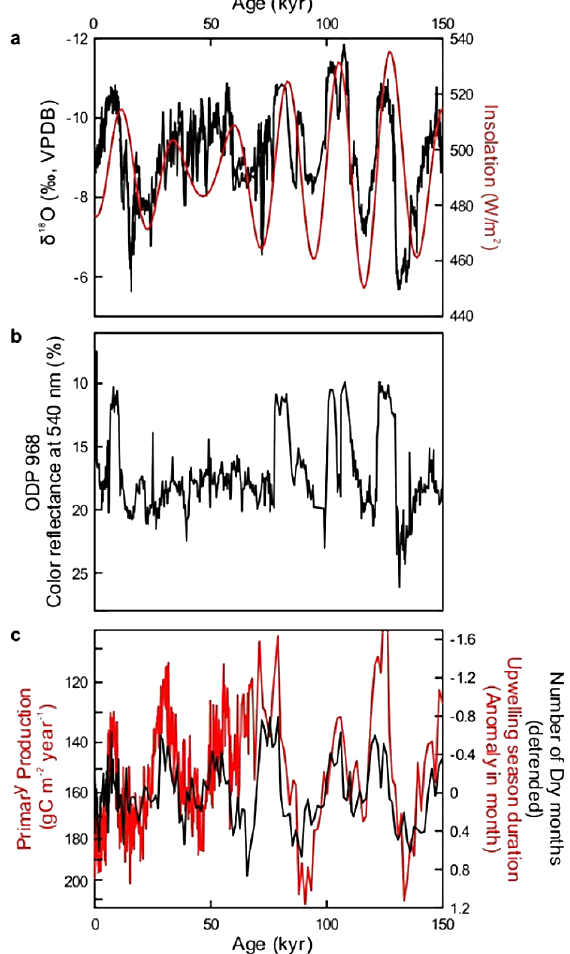
Figure 14. Comparative changes of Asian, North African and Aus- tralian monsoons over the past 150ka. (a) Asian monsoon variabil- ity inferred from the stalagmite δ 18 O record (black) from Hulu and Sanbao caves (Y. Wang et al., 2008). Insolation at 30 ◦ N (Berger, 1978) is shown in red. (b) North African monsoon variability in- ferred from the color reflectance from the ODP 968 eastern Mediter- ranean site (Ziegler et al., 2010b). (c) Australian monsoon vari- ability inferred from Banda Sea primary productivity, and its esti- mated upwelling season anomaly in months (red) and number of dry months reconstructed using palynology data (Beaufort et al., 2010). The two curves have the same scale in months on the right axis. The colors of labels to the right refer to the colors of the curves.